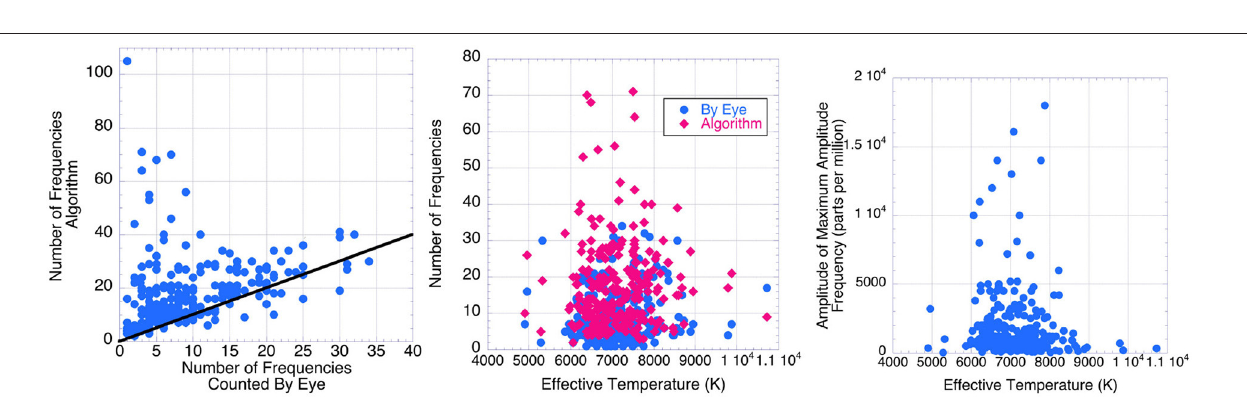
FIGURE 13 | Plot of number of modes per star with frequency > 5 c/d counted by eye vs. using Matlab algorithm (Left) , number of frequencies per star vs. T eff (Center) , and amplitude of maximum-amplitude mode vs. T eff (Right) for 249 δ Sct